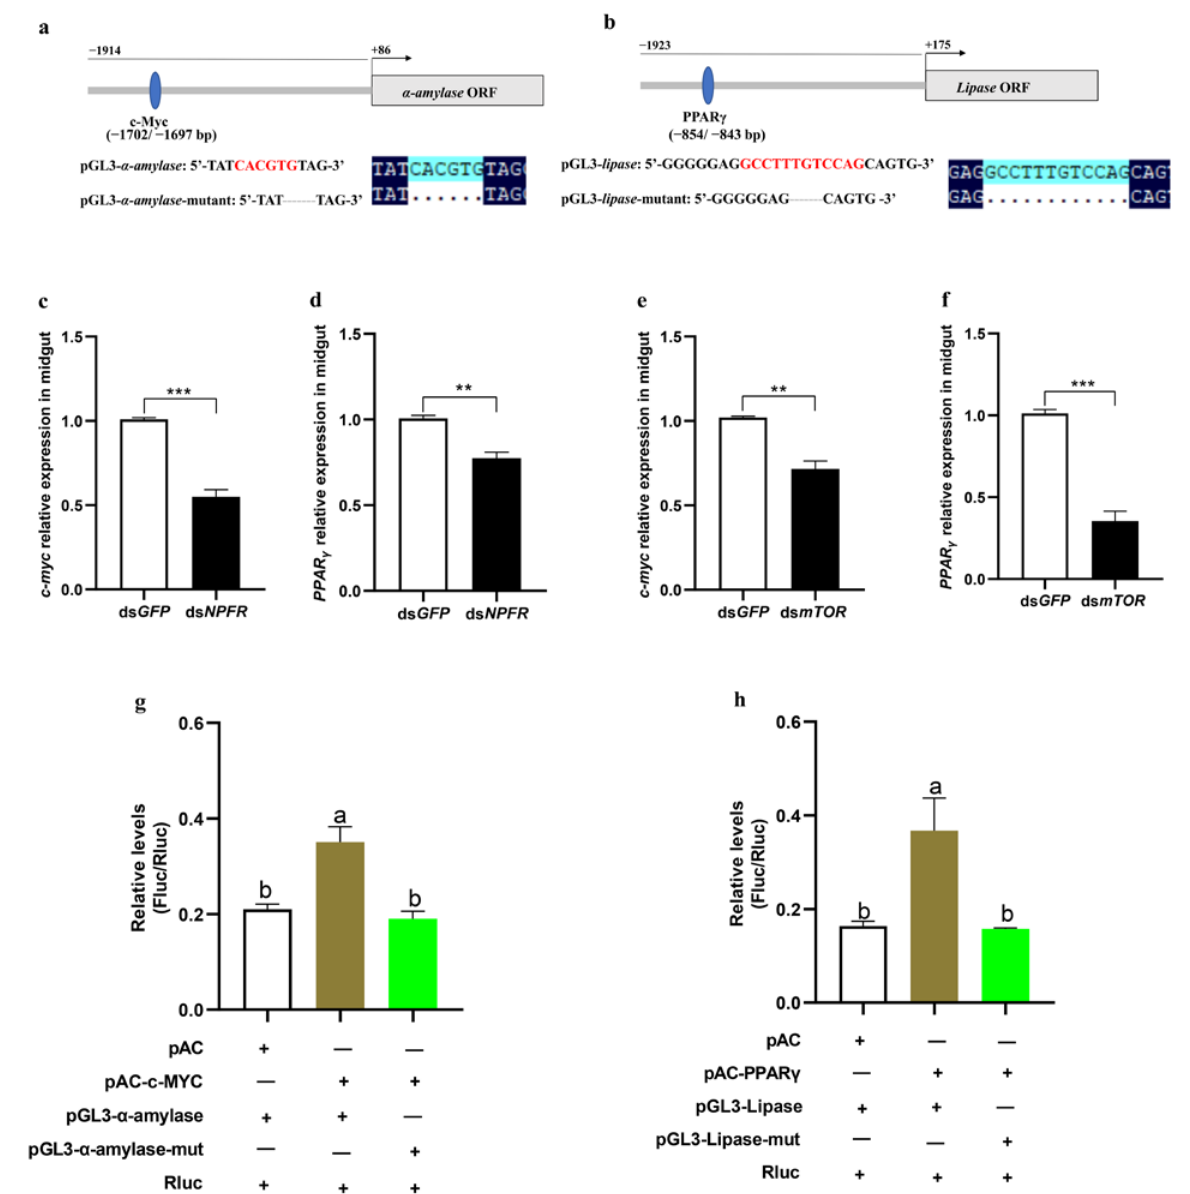
Figure 7. Identification of α -amylase and lipase targets. ( a , b ) Schematic representation of the location of c-Myc and PPAR γ response elements in the α -amylase and lipase promoter regions, respectively. Sequences of the predicted c-Myc and PPAR γ response elements. Red letters show the core nucleotides of c-Myc and the PPARγ binding motif. The grey bar and box indicate the promoter and coding region, respectively. The blue ellipses indicate c-Myc and PPARγ response elements. Numbers indicate the distance from the translation initiation site of α -amylase and lipase. ( c – f ) Relative expression levels of c-Myc and PPARγ in the midgut after NPFR and mTOR, respectively, were knocked down in 5th instar larvae for 24 h. ( g ) Luciferase reporter assays were performed after cotransfecting pAC and pAC- c - Myc or pGL-3- α -amylase and pGL-3- α -amylase- mut of the α -amylase binding sites. In all cases, cotransfection with Renilla reniformis luciferase was performed. ( h ) Luciferase reporter assays were performed after cotransfecting pAC and pAC- PPARγ alone or with pGL-3-lipase or pGL-3-lipase-mut of the lipase binding sites. In all cases, cotransfection with Renilla reniformis luciferase was performed. “+” indicates presence, while “–” indicates absence. Each treatment was repeated 3 times. Bars represent the mean ± SE, ** p < 0.01, *** p < 0.001. Different letters above the bars indicate significant differences at p < 0.05 as determined by Duncan’s multiple range test.